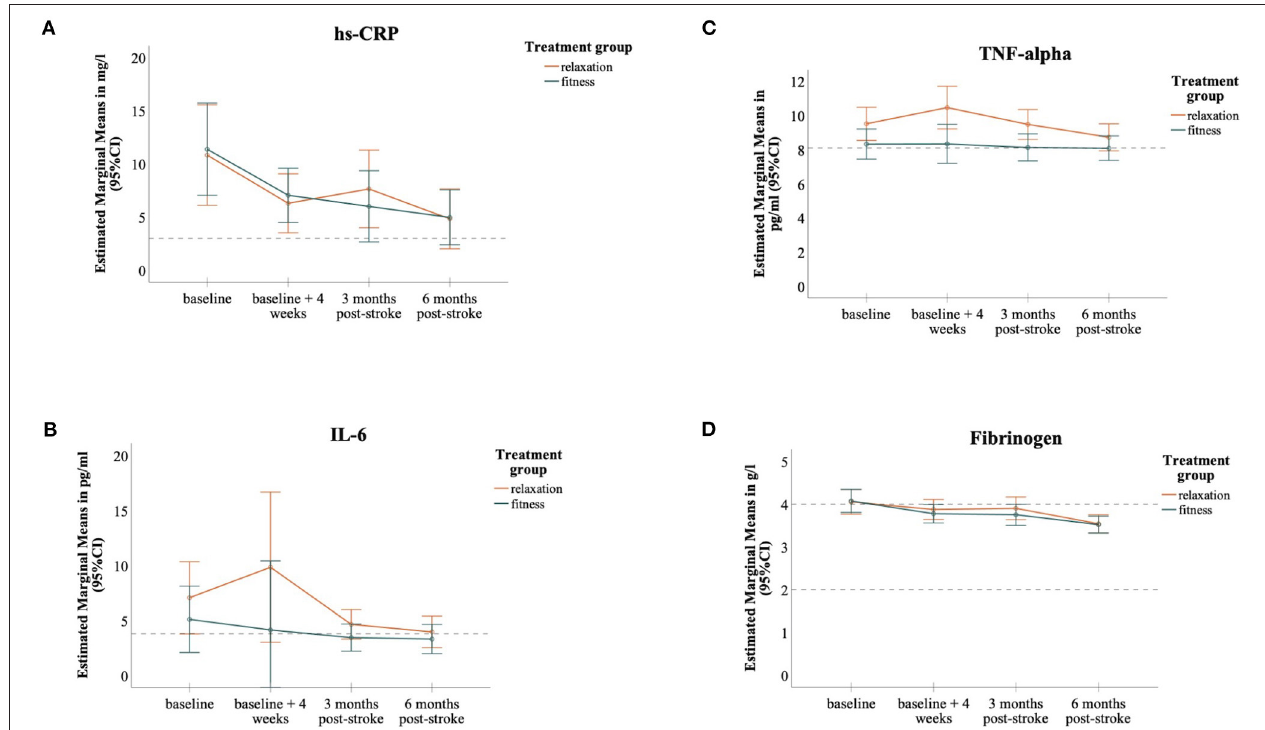
FIGURE 2 | MANOVA-Models, Dynamics of inflammatory biomarkers separated into the two treatment groups; hs-CRP (A) , IL-6 (B) , TNF-alpha (C) , fibrinogen (D) ; Levels of markers are expressed as Estimated Marginal Means, 95% CIs as error bars; horizontal dashed lines depict cut-off for normal ranges.